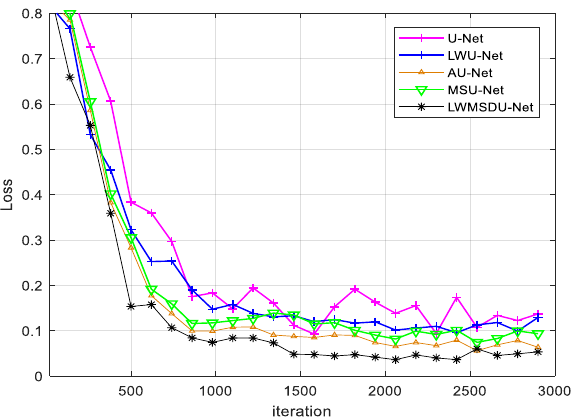
Figure 9. Segmentation accuracy versus the number of iterations of four networks.